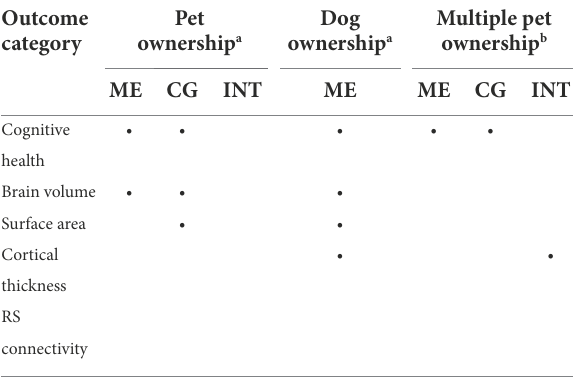
TABLE 3 Summary of multivariate statistics by group membership.